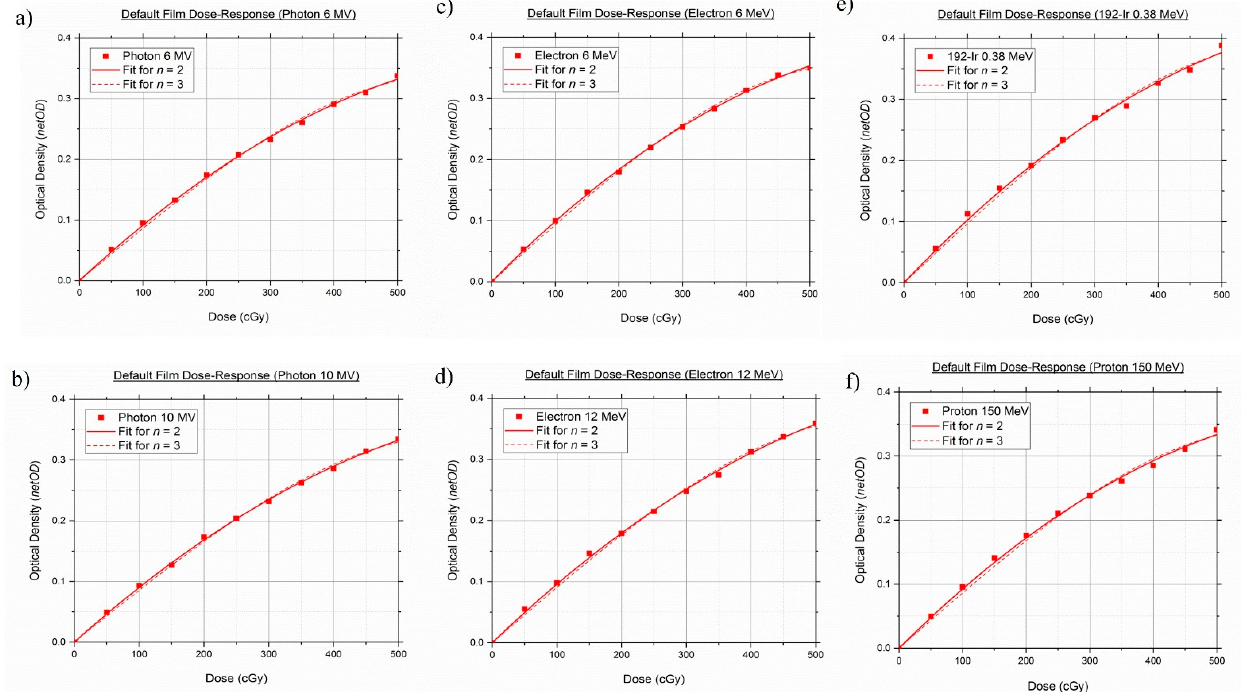
Figure 4. Default dose–response curves of standard GAFCHROMIC™ EBT3 films in two fitting